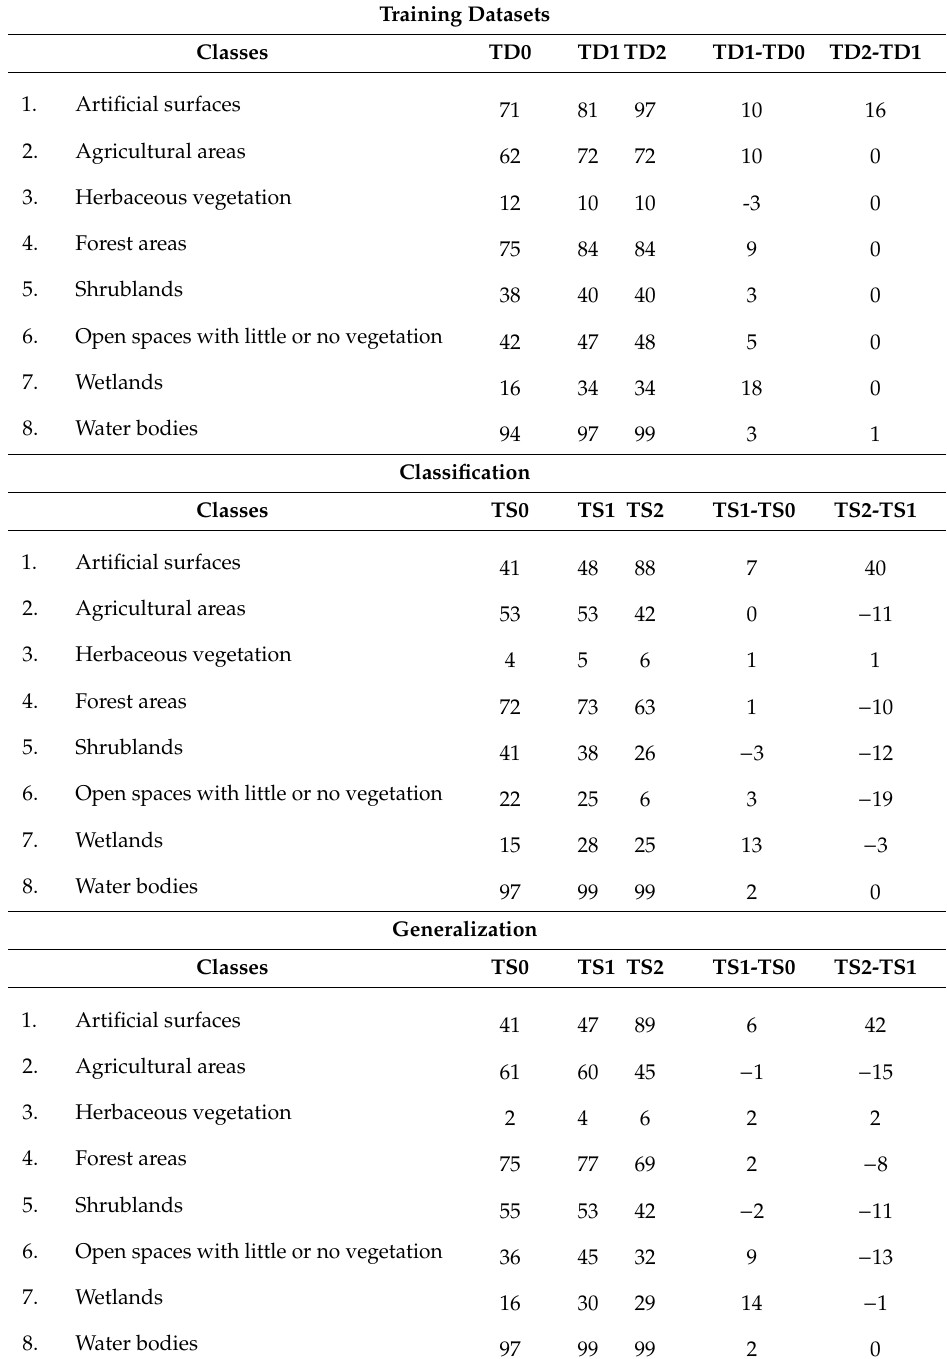
Table 9. User’s Accuracy per class (%) (equal to 100 minus the commission errors), for study area A, of the training datasets TD0, TD1 and TD2 and of the maps resulting from the classification with TS0, TS1 and TS2 (Figure 11). The reference data used are the maps derived from the COS 2018 with the nomenclature